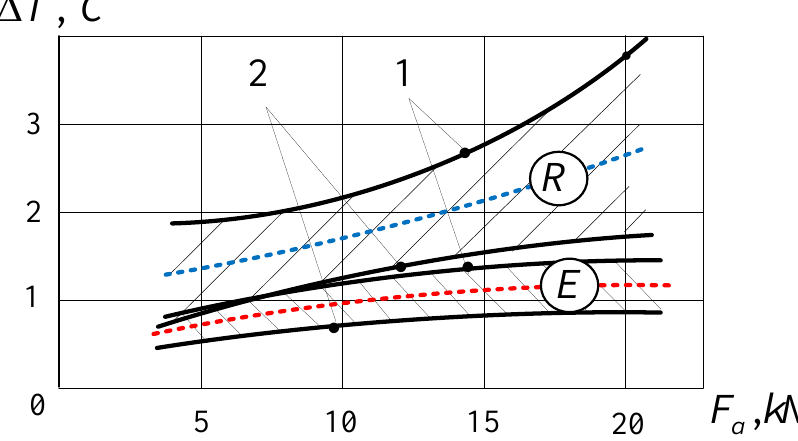
Figure 4. The temperature gradients diagrams for a typical design of a cylindrical roller bearing (region R, z = 14) and a modernized one (region E, z = 16): curve 1— F r = 50 kN, V = 200 km/h; curve 2— F r = 30 kN, V = 100 km/h.